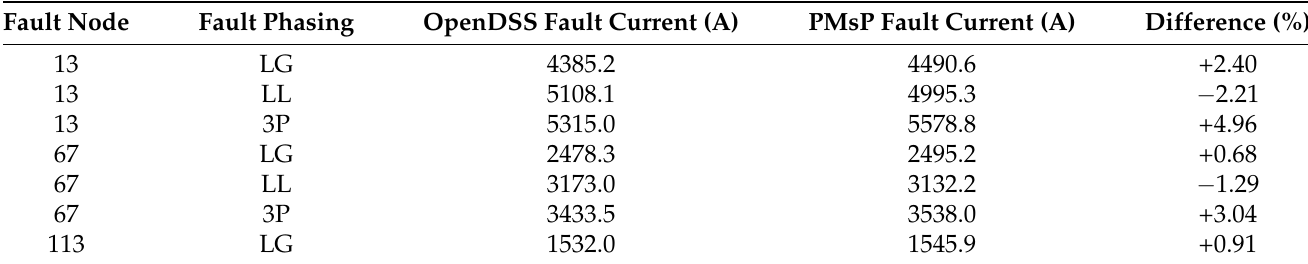
Table 3. Comparison of results for configuration GflI-M-GC of the IEEE 123-Node System.